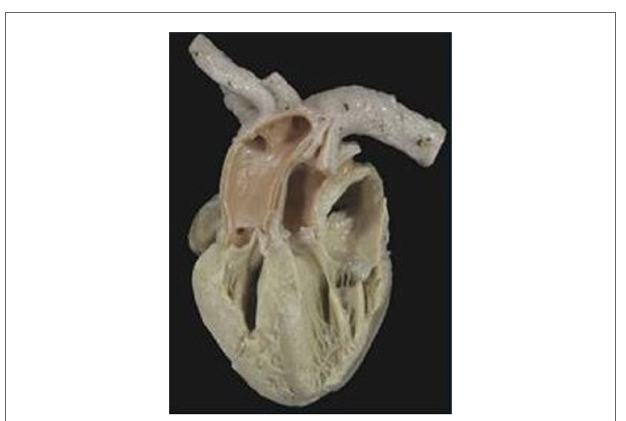
FigUre 2 | complete Tga with intact septum . Anatomical specimen showing the origin of the pulmonary trunk from the left ventricle and of the aorta from the right ventricle (discordant VA connection). The ventricular septum is intact. Note the AV concordance and parallel fashion of the great arteries.